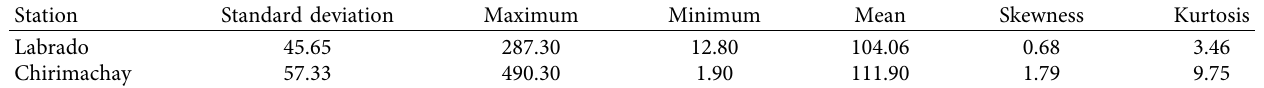
Table 1: Statistical summary of stations rainfall